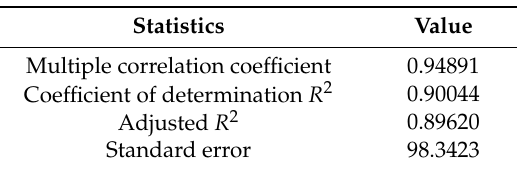
Table 4. Statistics of the